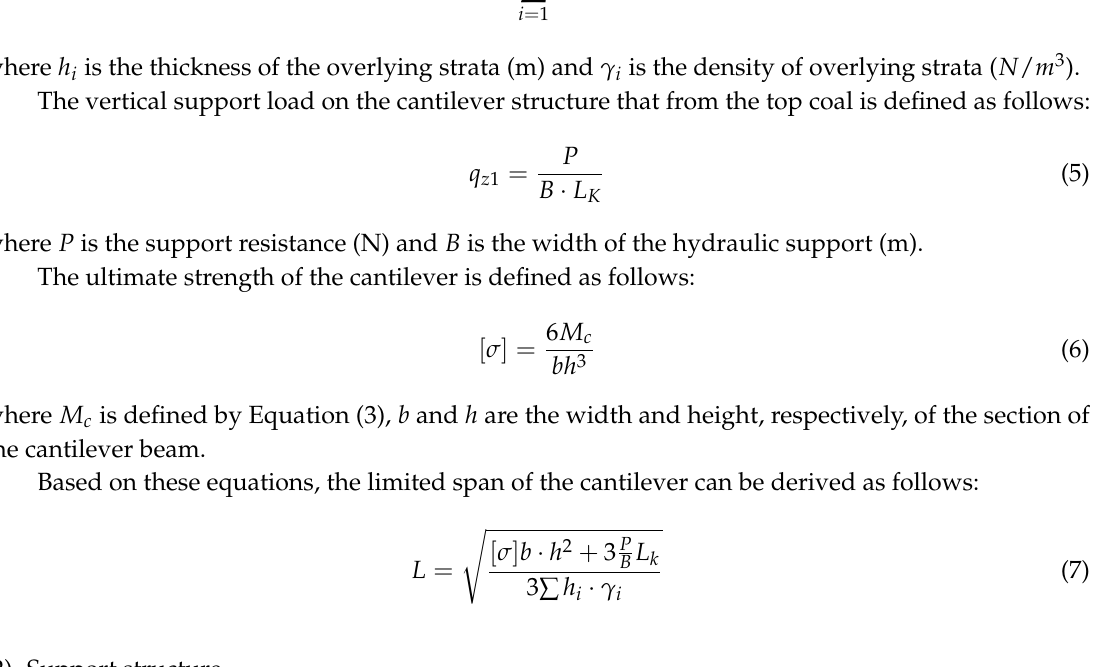
Figure 8. Support structure of KS1.